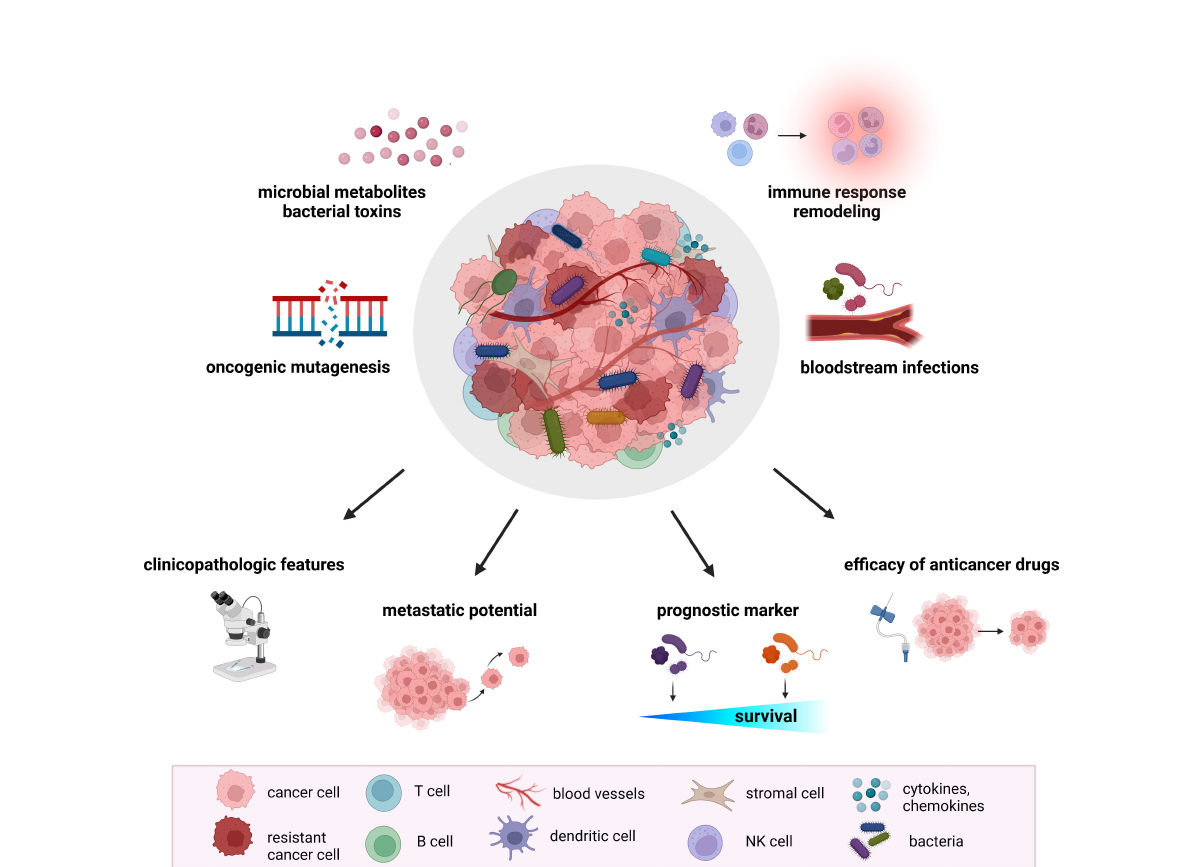
FIGURE 1 The role of tumor microbiome in cancer development and treatment. Proposed mechanisms by which the tumor microbiome affects tumorigenesis, cancer progression, and response to therapeutic agents include increased mutagenesis, regulation of oncogenes and oncogenic pathways, modulation of host immune response pathways, cancer drug metabolism, production of bacterial toxins and microbiota-derived metabolites. Mounting evidence from animal models and clinical studies revealed the association of tumor microbiome with clinicopathologic features, cancer treatment ef fi cacy, metastatic potential, and cancer